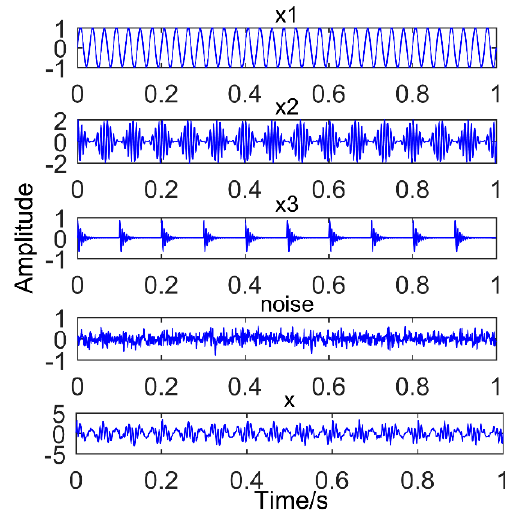
Figure 12. Time domain diagram of the simulated signal.